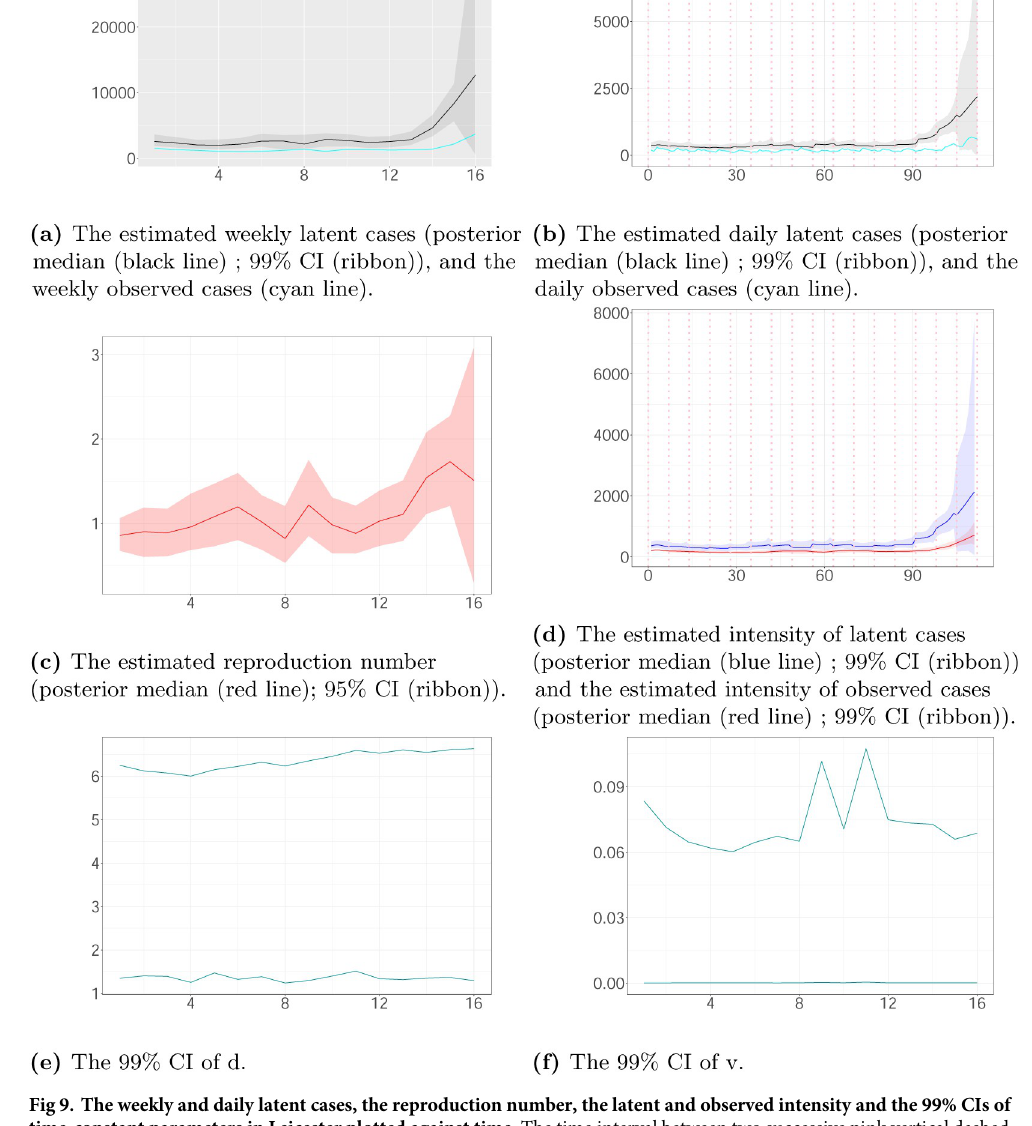
Fig 9. The weekly and daily latent cases, the reproduction number, the latent and observed intensity and the 99% CIs of time-constant parameters in Leicester plotted against time. The time interval between two successive pink vertical dashed lines corresponds to a week. (a) The estimated weekly latent cases (posterior median (black line); 99% CI (ribbon)), and the weekly observed cases (cyan line). (b) The estimated daily latent cases (posterior median (black line); 99% CI (ribbon)), and the daily observed cases (cyan line). (c) The estimated reproduction number (posterior median (red line); 95% CI (ribbon)). (d) The estimated intensity of latent cases (posterior median (blue line); 99% CI (ribbon)) and the estimated intensity of observed cases (posterior median (red line); 99% CI (ribbon)). (e) The 99% CI of d. (f) The 99% CI of v.